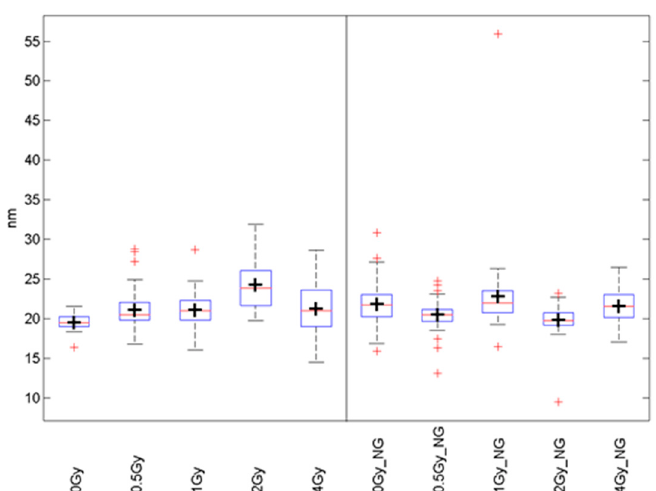
Figure 9. Boxplots of distance frequencies between γ H2AX labelling tags in SkBr3 cell nuclei of irradiated specimens (left) and Au-NP-incorporated and irradiated specimens (NG, right). (black cross: mean value; red line: median value; red cross: outliner; blue box: first quartile; dashed line: standard deviation)